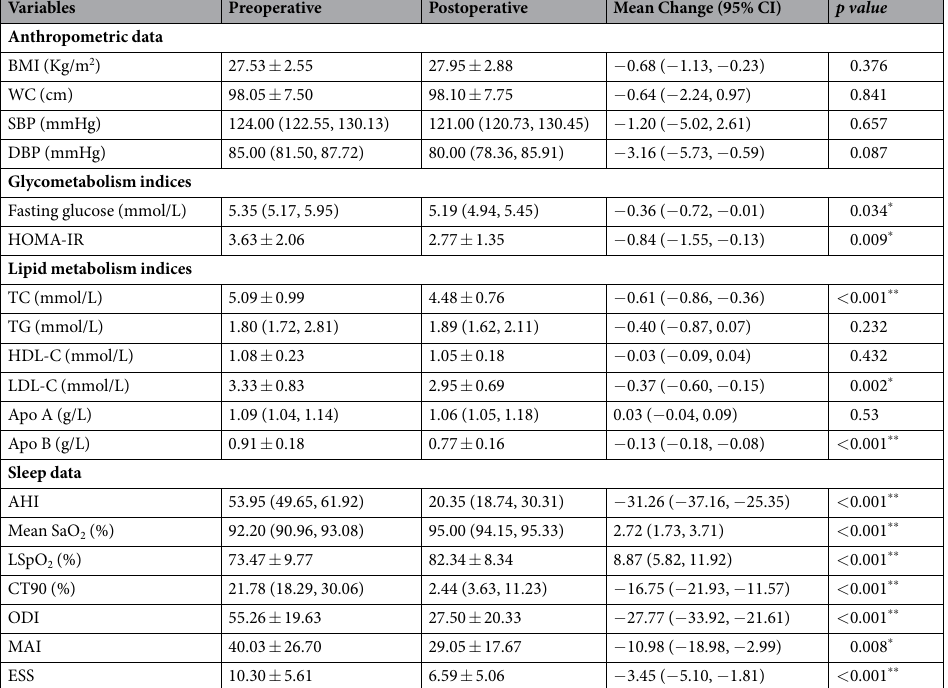
Table 2. Comparisons of levels of glucolipid metabolism biomarkers and sleep parameters between preoperative and postoperative. Abbreviations: BMI = body mass index, WC = waist circumference, SBP = systolic blood pressure, DBP = diastolic blood pressure, HOMA-IR = homeostasis model of assessment for insulin resistance index, TC = total cholesterol, TG = total triglycerides, HDL-C = high-density lipoprotein cholesterol, LDL-C = low-density lipoprotein cholesterol, Apo A = apolipoprotein A, Apo B = apolipoprotein B, AHI = apnea-hypopnea index, SaO 2 = oxygen saturation, LSpO 2 = lowest pulse oxygen saturation, CT90 = percentage of time during which oxyhemoglobin saturation was < 90%, ODI = oxygen desaturation index, MAI = micro-arousal index, ESS = Epworth Sleepiness Scale, CI = confidence interval. * p < 0.05; ** p <